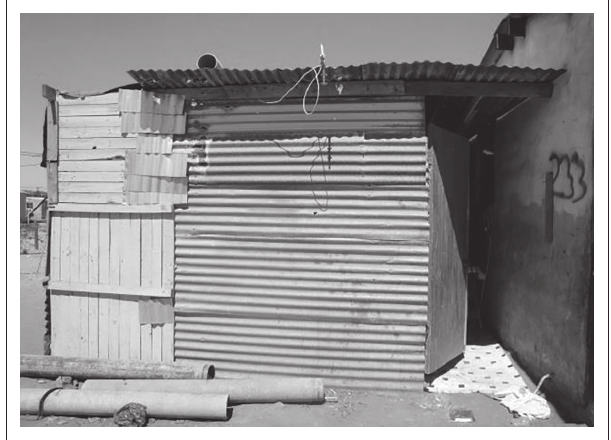
FIGURE 1: Example of rudimentary